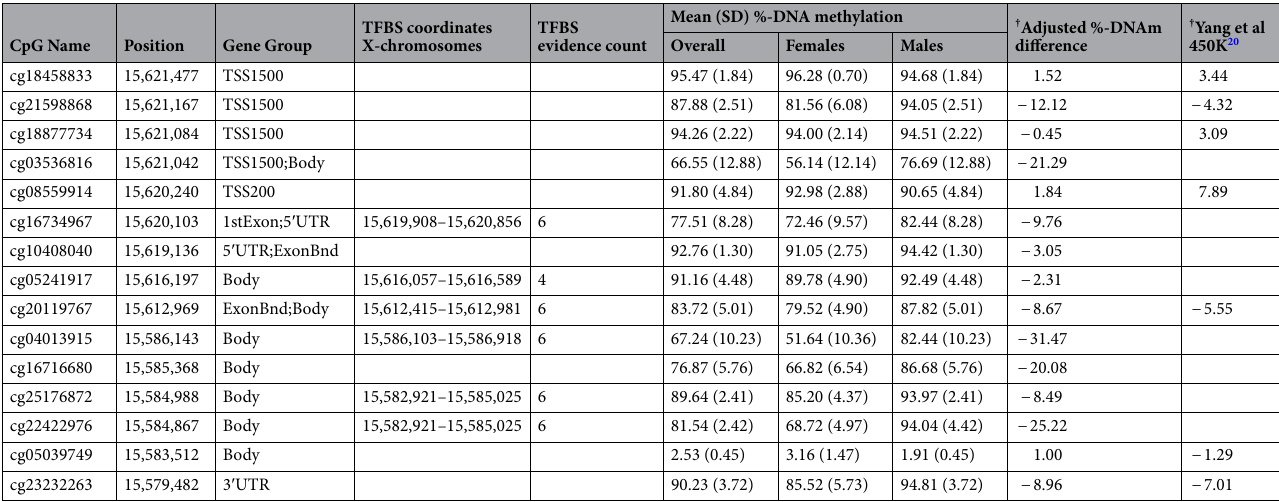
Table 1. Genomic annotation of probes located within the Illumina EPIC array and nasal DNA methylation descriptive statistics for the angiotensin-converting enzyme ( ACE2 ) gene located in the X-chromosome and sex differences. † Differences in DNAm for females relative to males adjusted by age from a multivariate regression models all results were significant at FDR <